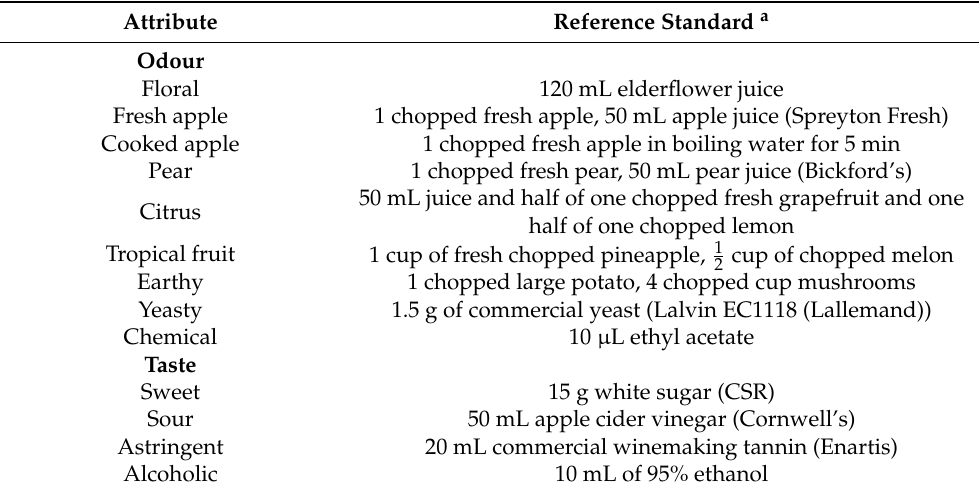
Table 1. Sensory attributes chosen by sensory panel and corresponding reference standards’ compo-